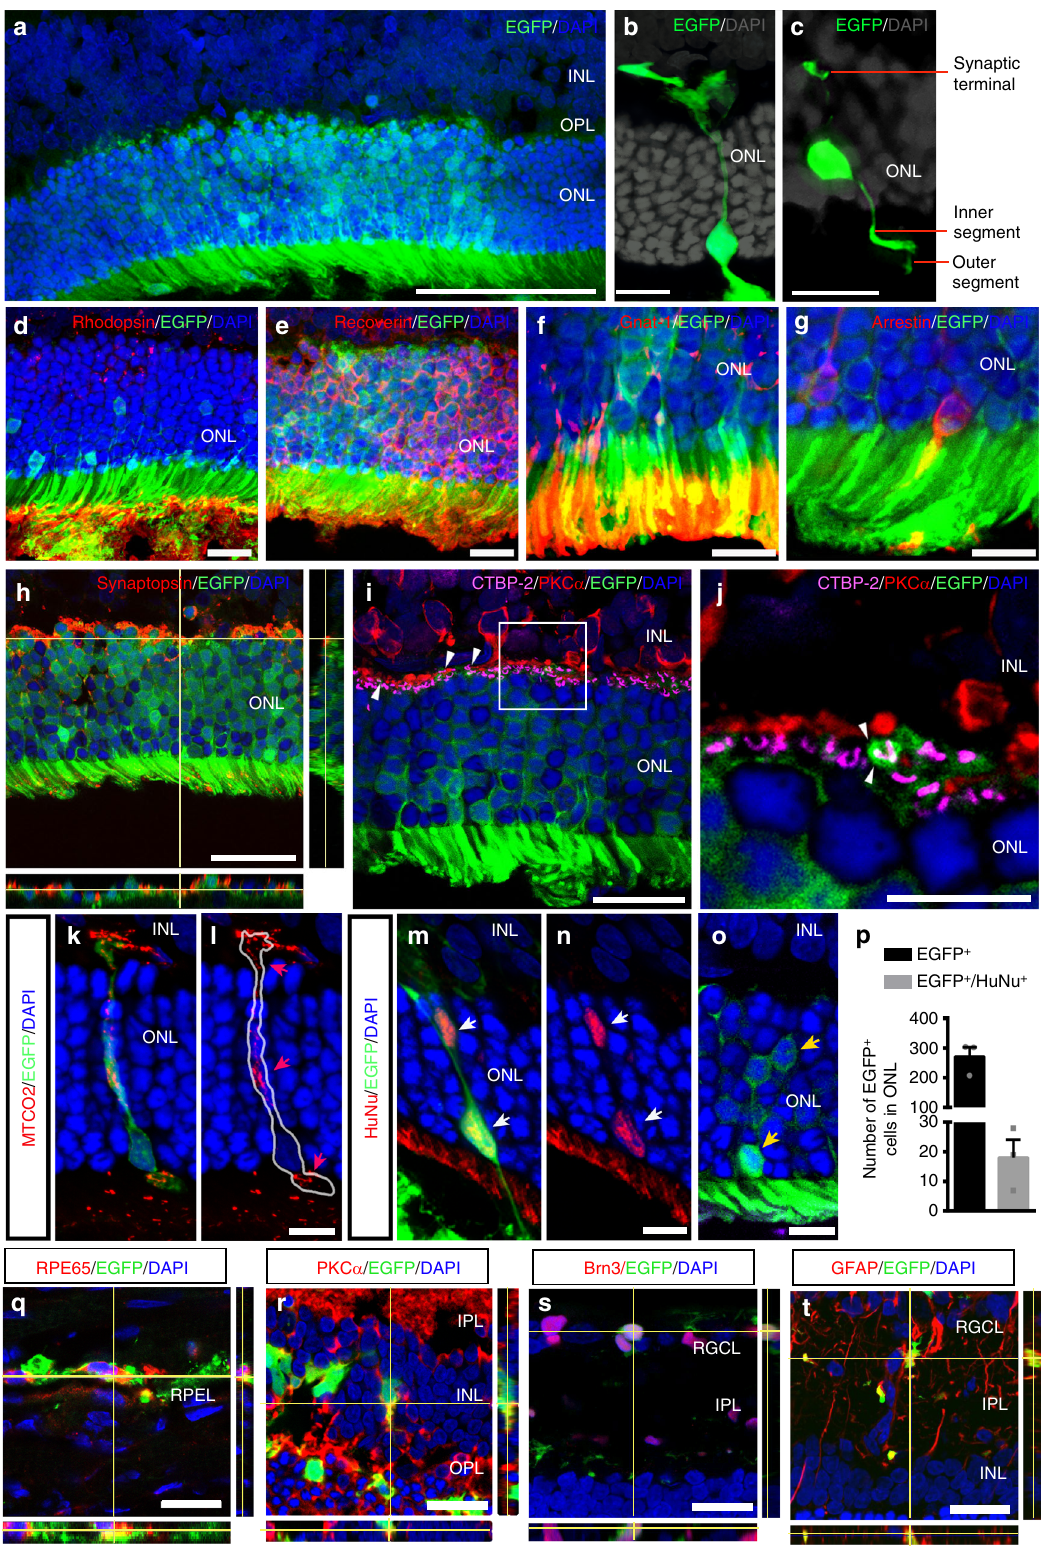
(Fig. 7a). Similar to the pattern of microglial suppression (Fig. 6d), we observed a remarkable difference in GFAP expression in grafted and non-grafted areas of the same retinas of RCS rats at PO 8w (Fig. 7b). The suppression of gliosis was also indicated by GFAP Western blot analysis (Fig. 7c,